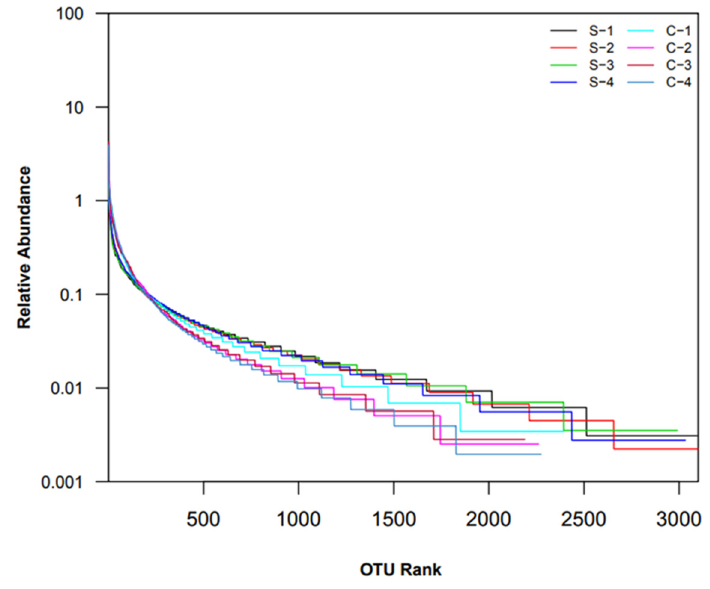
Figure 3. Rank-abundance distribution curve of different bacterial communities. Table 3. Alpha-diversity estimators of the rhizosphere bacterial communities.